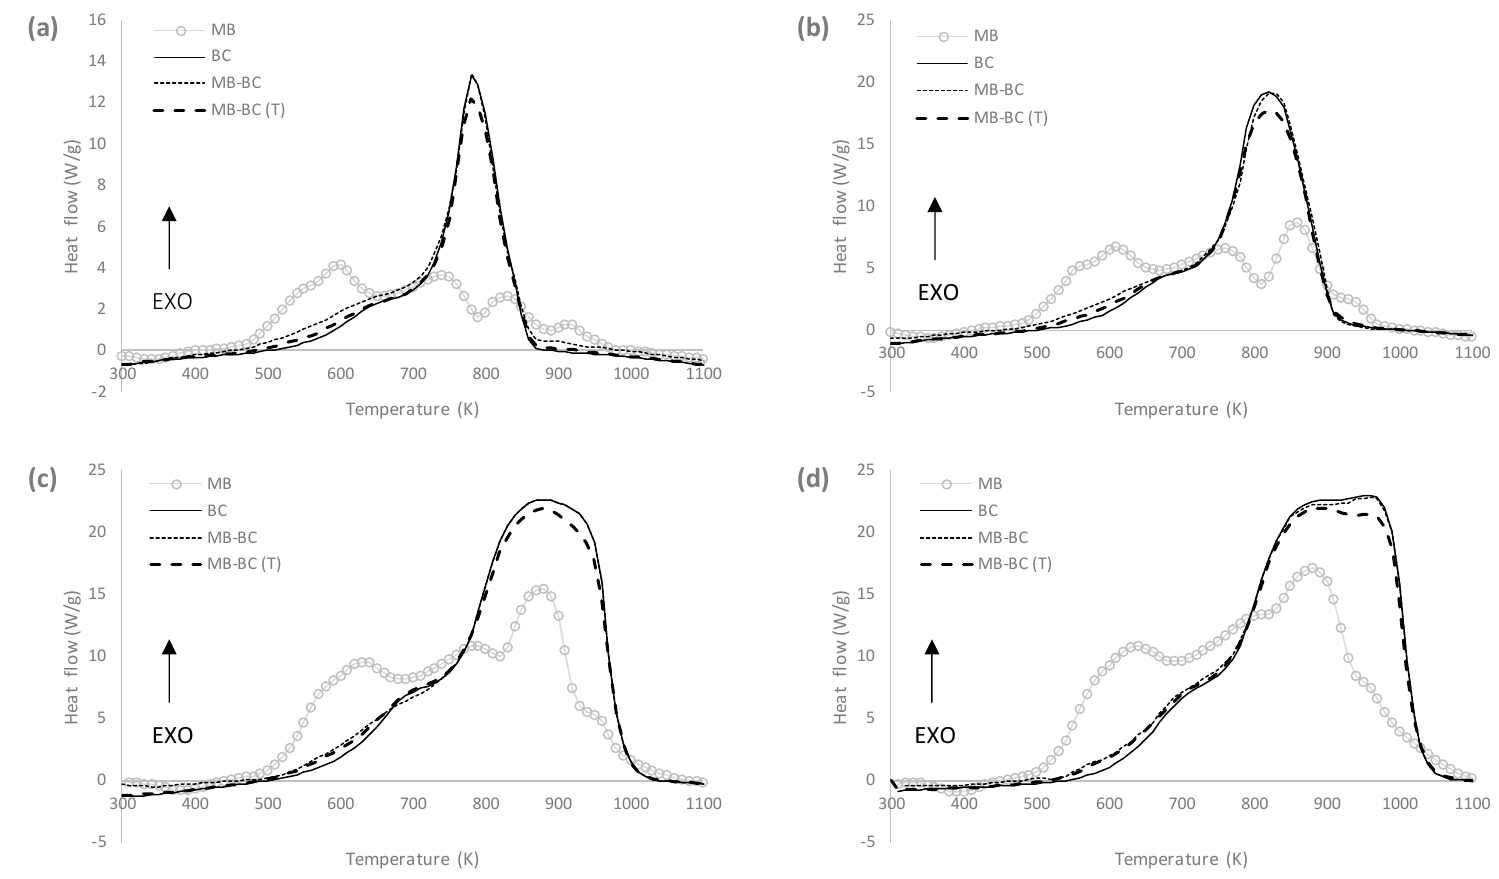
Figure 3. Di ff erential scanning calorimetric (DSC) curves corresponding to the temperature programmed combustion of MB, BC and their blend (MB-BC) together with the weighted calculated curve corresponding to the blend (MB-BC (T)) at the di ff erent heating rates here used, namely 0.1 K / s ( a ), 0.2 K / s ( b ), 0.4 K / s ( c ) and 0.5 K / s ( d ).